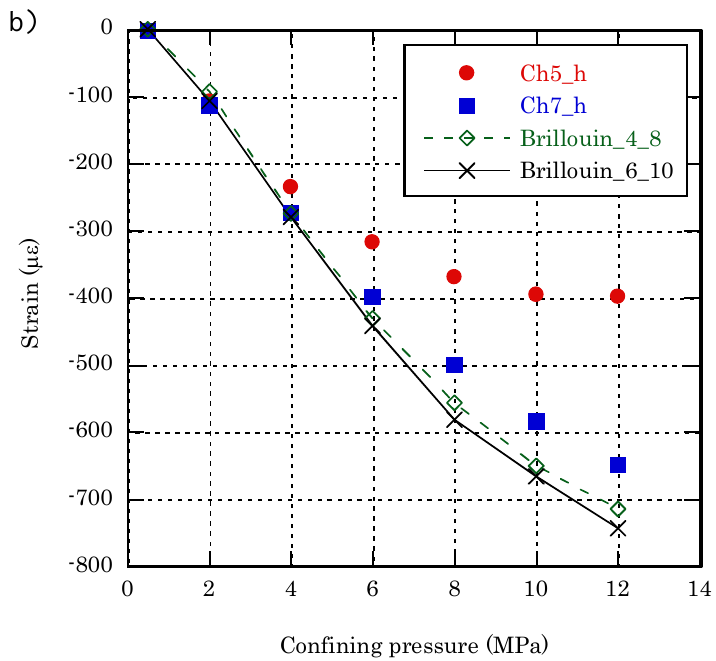
Figure 14. Frequency shift to strain conversions for Berea core vs. strain gauge measurements with increasing confining pressure. On a whole, the converted strains from both Rayleigh frequency shift ( a ) and Brillouin frequency shift ( b ) agree reasonably well with the strain gauge readings from Ch7.